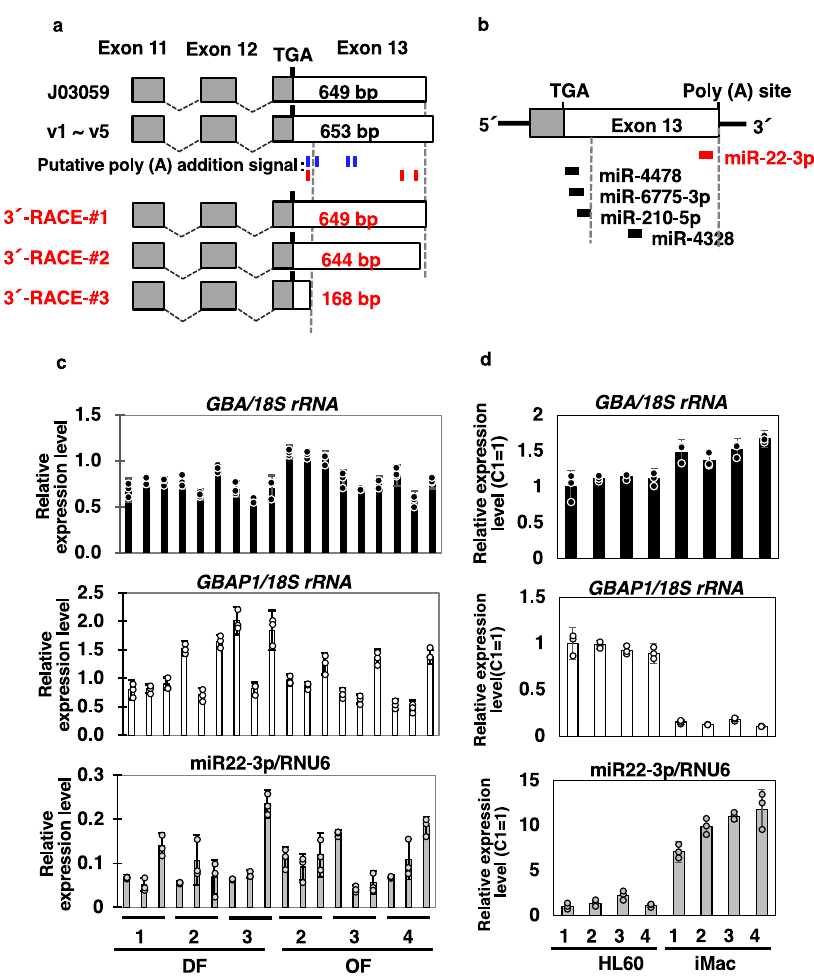
Fig. 8 Analyses of the GBA 3 ’ end. a Summary of GBA 3 ’ -RACE. The top 2 lines indicate the known structures of J03059 and GBA variants v1 to v5. #1 – 3 are the results of this study. The boxes indicate the exons. Gray, coding region; white, UTR. The number is the size of exon 13. In the middle, the positions of putative poly (A) addition signals are indicated in blue (Horowitz, et al. 8 ) and red (Beaudoing et al. 32 ). b In silico analysis of miRNA binding to GBA . Red, miR22-3p based on Straniero et al. 10 ; black, database search results obtained using miRDB. c , d Gene expression of GBA , GBAP1 and miR22-3p in fi broblasts ( c ) and HL60 derivatives ( d ). The qPCR results for GBA and GBAP1 were normalized to 18 S rRNA expression, whereas miR22-3p was normalized to RNU6 expression, respectively. In d , after normalized expression value, calibrated as a relative quantity to no-treated HL60 (C1). Black bar, GBA ; white bar, GBAP1 ; gray bar, miR22-3p. Each experiment was performed in triplicate. Data represent the mean ±